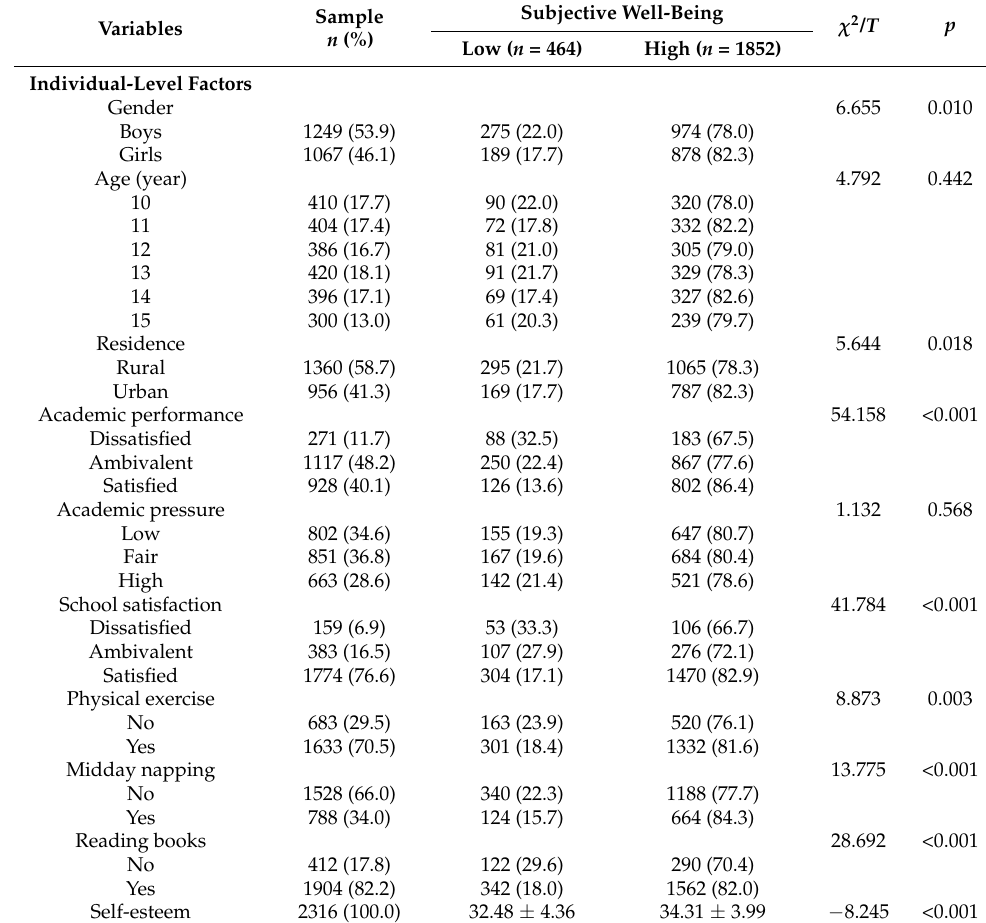
Table 1. Univariable analysis of factors associated with subjective well-being (SWB) among Chinese adolescents (N =